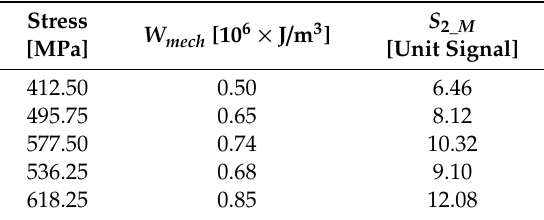
Table 3 resumes the values that were calculated for each parameter. Table 3. Damage index